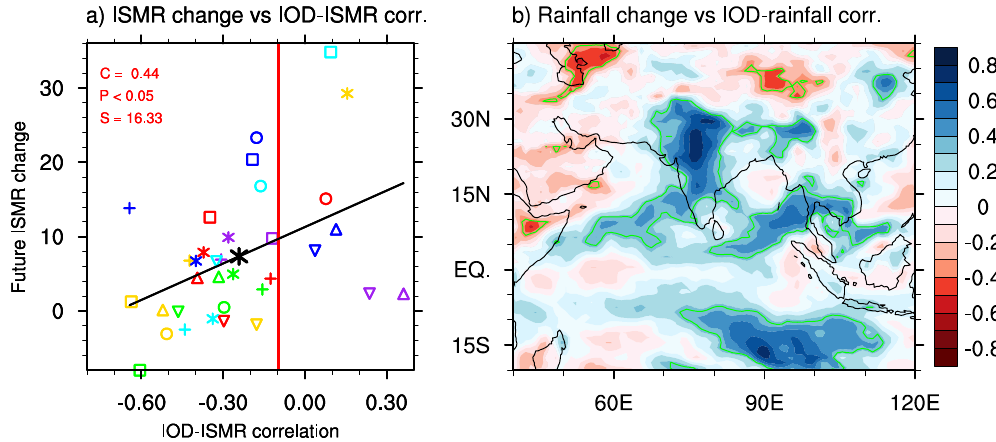
Figure 4. Inter-model relationship between future projections with present-day simulations. Inter-model variations in the present-day IOD-ISMR correlation versus variations in ( a ) future ISMR change (units: % per °C of global warming), and in ( b ) grid-point future rainfall change (units: % per °C of global warming) vs grid- point rainfall correlation with the IOD. In ( a ), the solid black line denotes the linear regression, and symbols for models are the same as in Fig. 3, and the red vertical line represents the observed IOD-ISMR correlation in present-day climate. Areas within green contours in ( b ) denote regions where the correlation is statistically significant above the 95% confidence level. The statistical significance is calculated using a two-tailed Student’s t -test. The plot and map were generated by NCL version 6.3.0